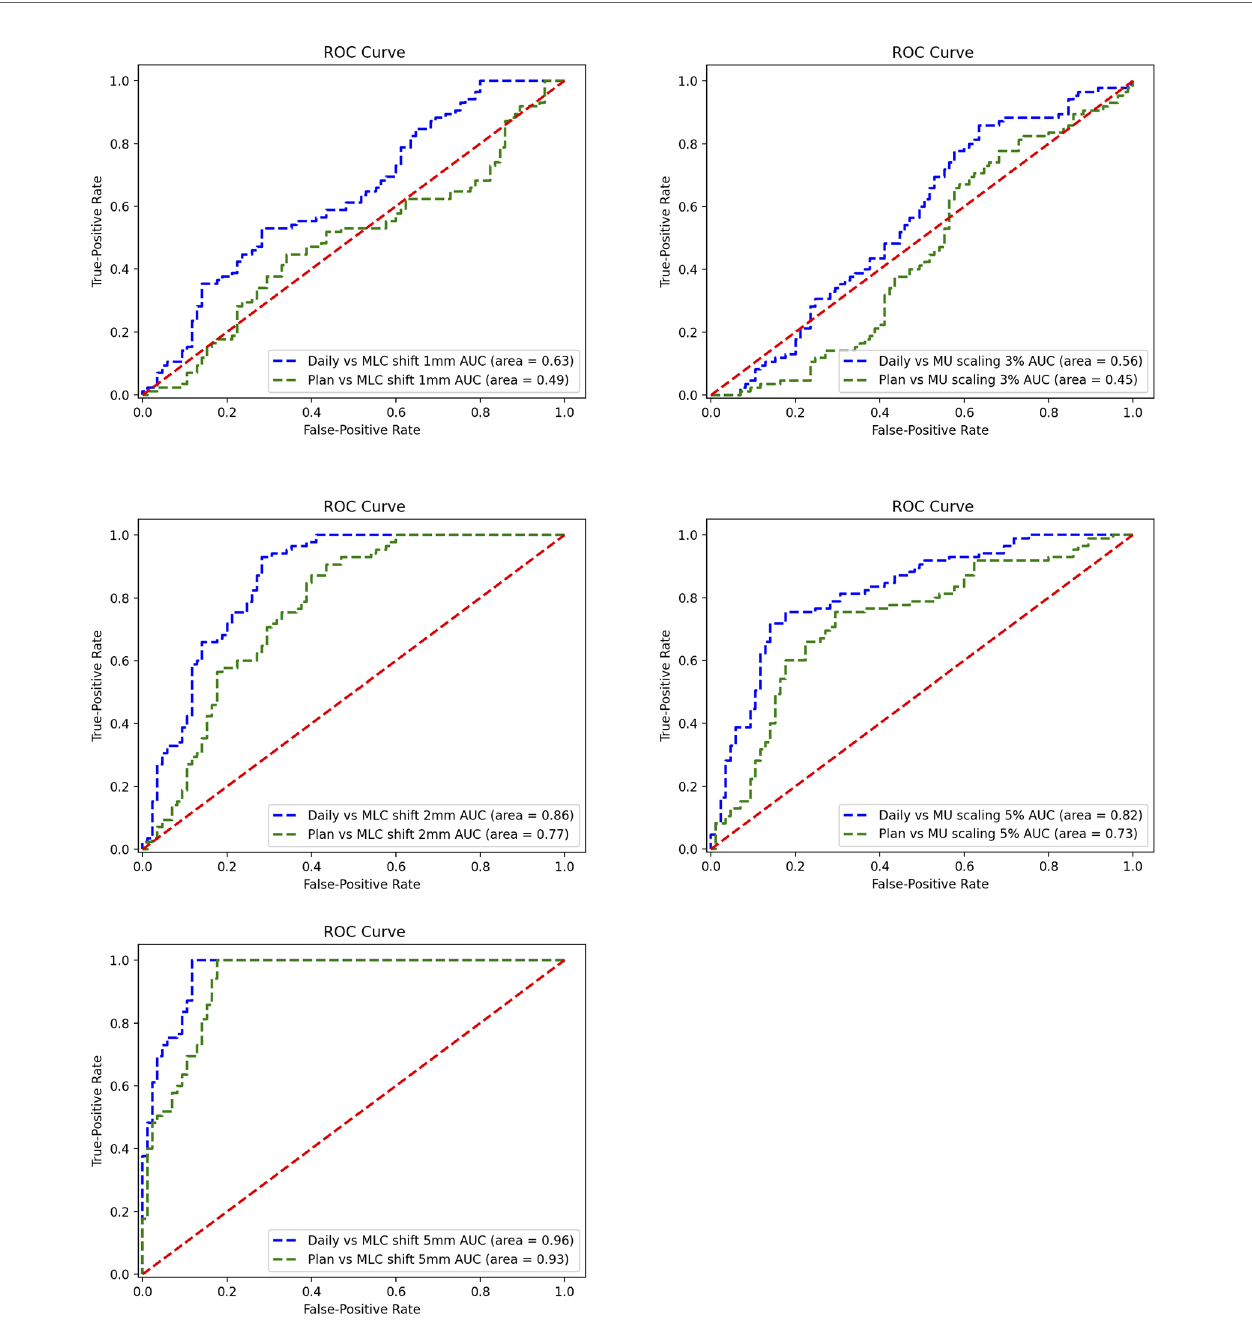
FIGURE 10 | Receiver operating characteristic (ROC) curve for a systematic shift to multileaf collimator (MLC) leaves of ±1, ± 2, and ±5 mm (left). ROC curve for scaling of the monitor unit (MU) by 3% and 5%